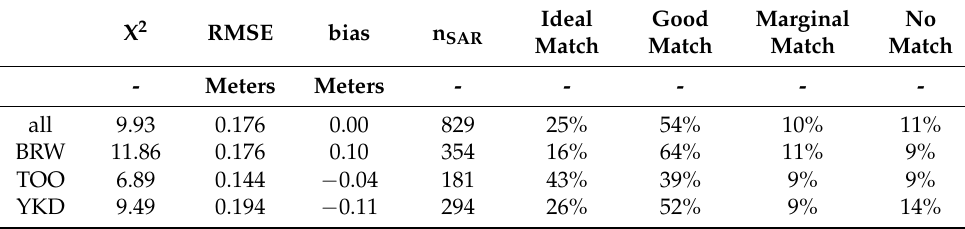
Table 2. Results of χ 2 classification. RMSE indicated root mean squared error, n SAR is the number of SAR pixels available for